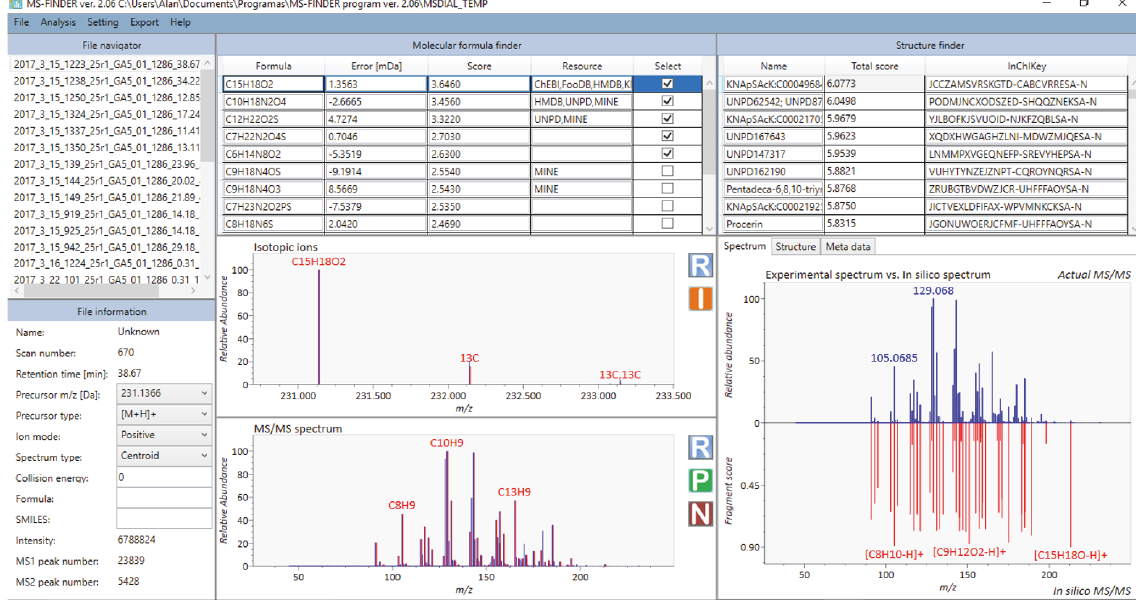
Figure5:MS-Finderscreenshotshowingresultsfortheprecursorion m/z 231.1367.Experimental(red)andtheoretical(blue)isotopicpatterns and MS/MS are included together with the fragment score plot. The list of candidate formulas with mass error and score is also presented and, for the selected formula, possible structures found in database search are